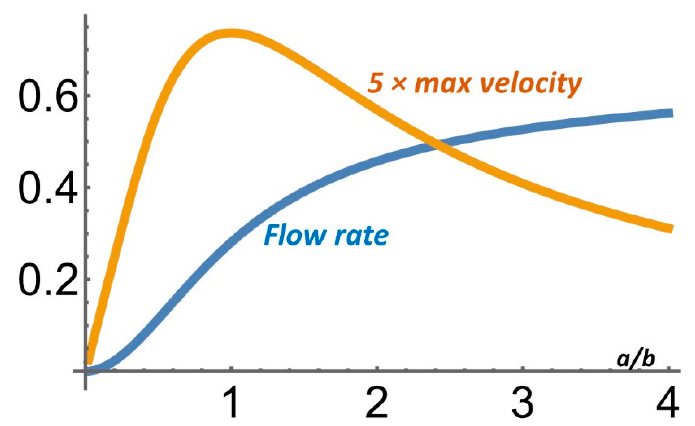
Figure 2. A MHD pump operating under potentiometric conditions in the absence of a pressure gradient and with the potential difference ∆ V across the electrodes. The dimensionless maximum gradient and with the potential difference Δ V across the electrodes. The dimensionless maximum ( 0,0 ) µ v ( 4 u z ab ) µ v velocity u z and the dimensionless flow rate are depicted as functions of the aspect b σ ∆ VB 0 b 3 σ ∆ VB 0 ratio a/b . When a/b- > 0 , the maximum velocity ~ a/(4b) velocity are depicted as functions of